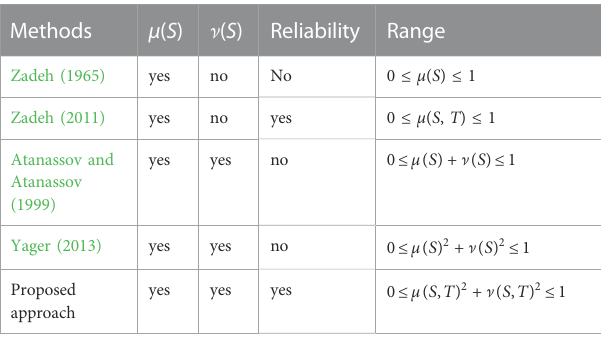
TABLE 1 Comparison with existing studies.